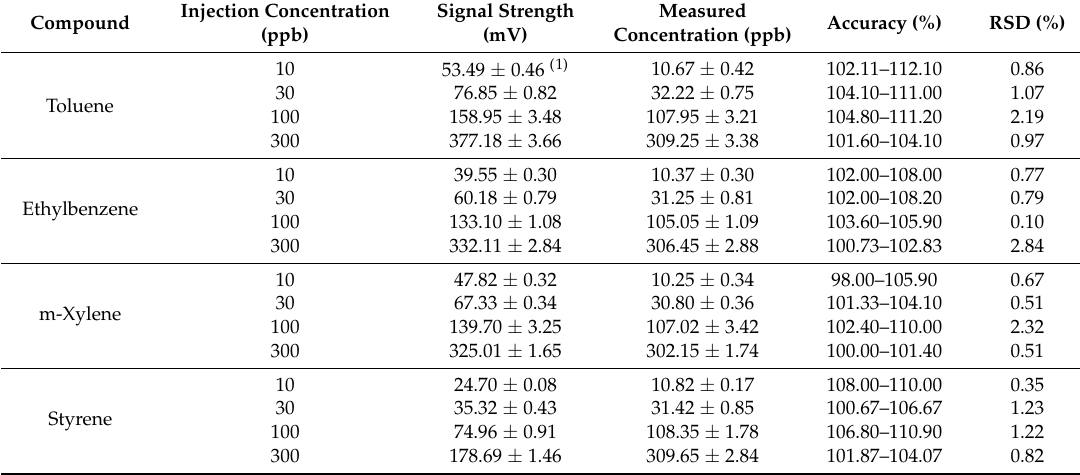
Table 6. Comparison of VOCs concentrations for accuracy.